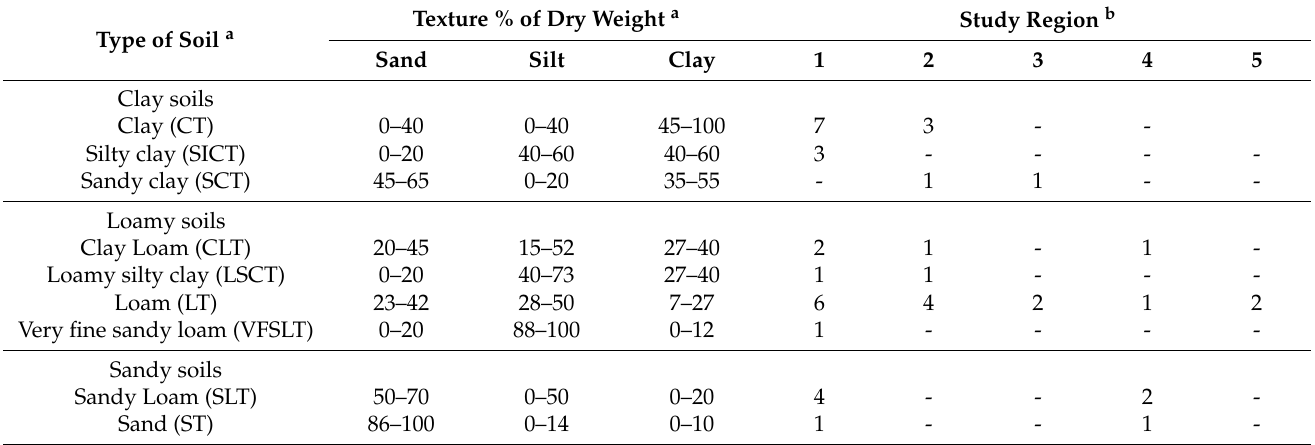
Table 2. Site distribution by soil textural class in the five study regions.